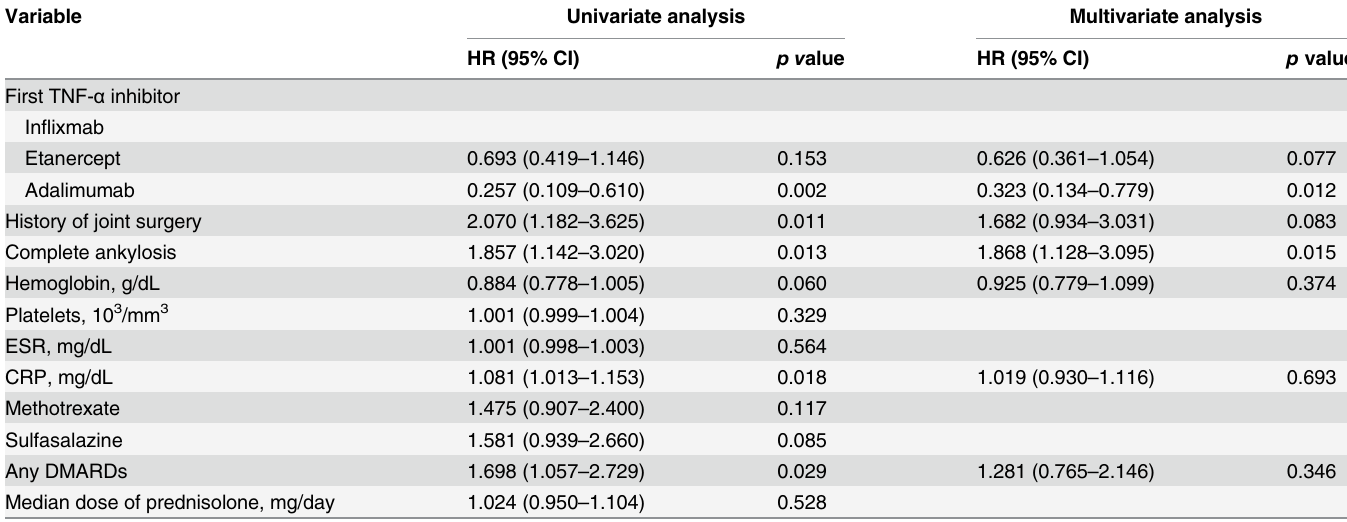
Table 4. Predictors of TNF- α inhibitor